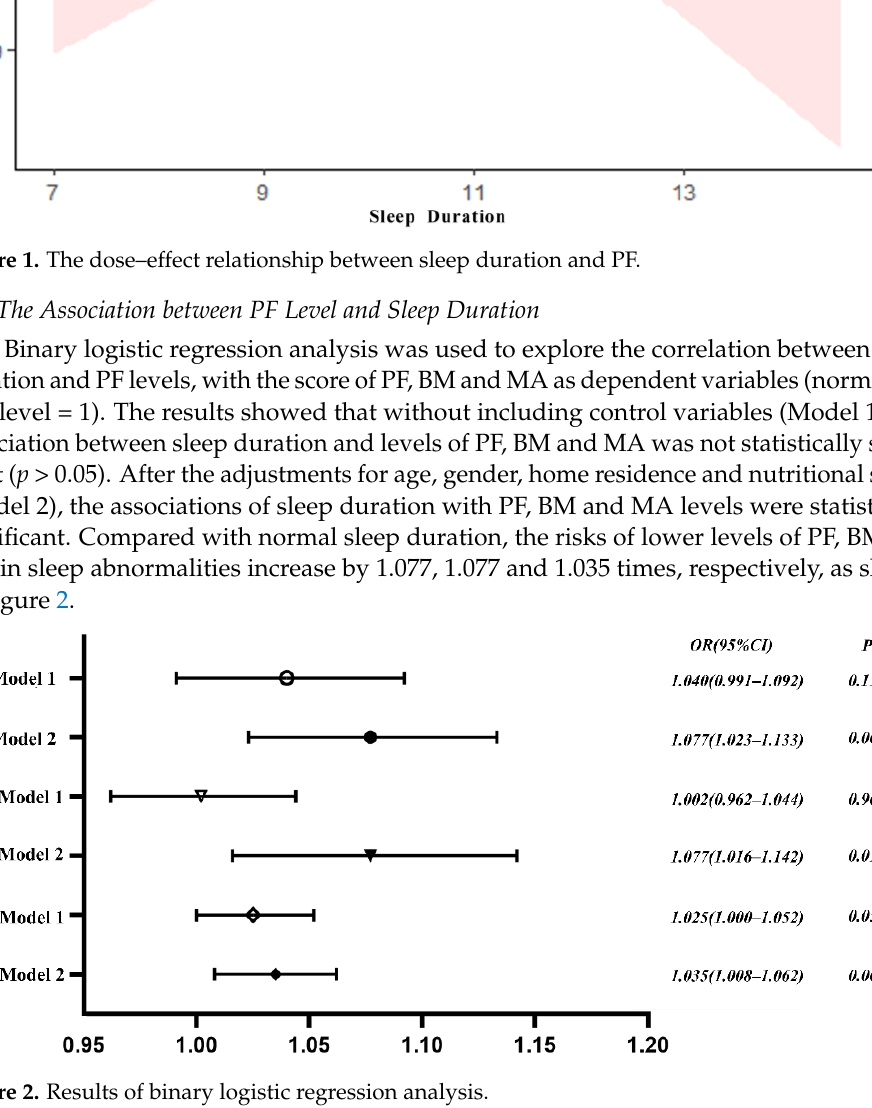
Figure 2. Results of binary logistic regression